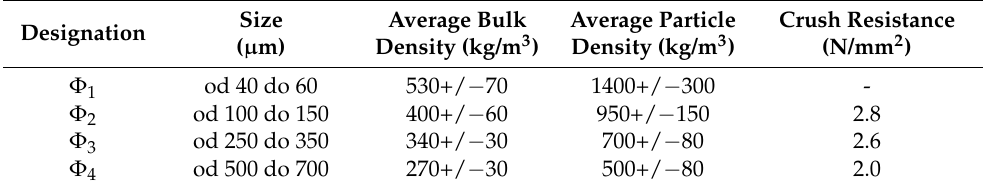
Table 1. Selected physical properties of the microspheres